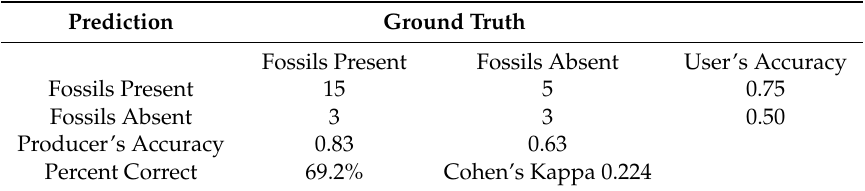
Table 4. Retrospective results of 2013 field season from the Landsat 7 ANN-based predictive model.